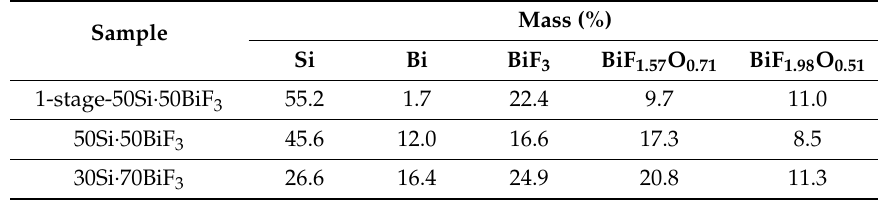
Table 3. Compositions of the prepared Si · BiF 3 composites obtained from the whole pattern refinement of the XRD traces.